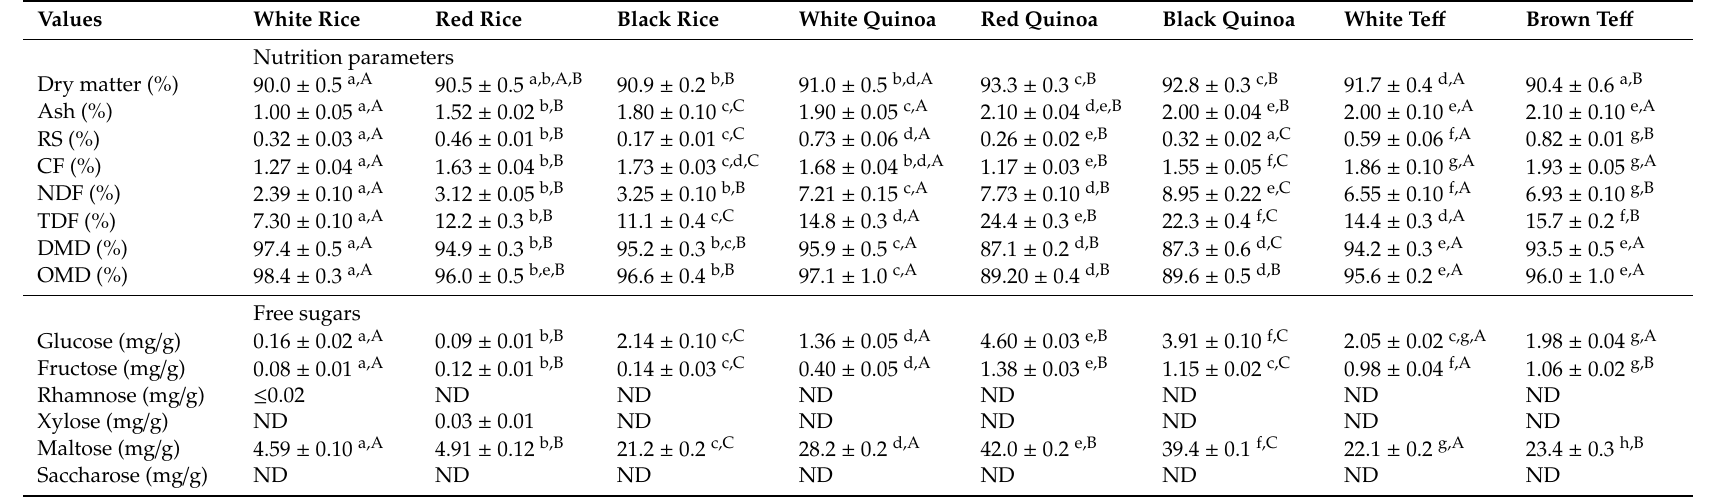
Table 1. Results of basic nutrition parameters and free sugar contents in non-traditional